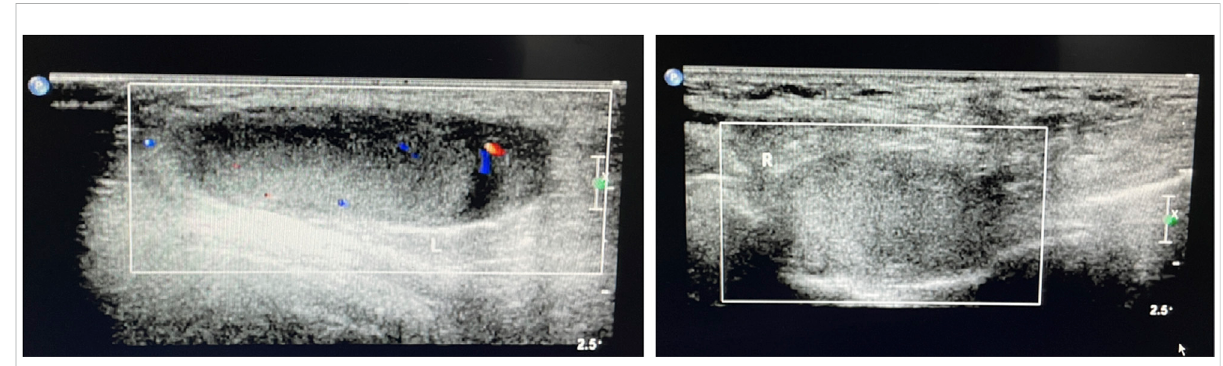
FIGURE 3 Ultrasound of the bilateral subcutaneous masses in the genital area consistent with